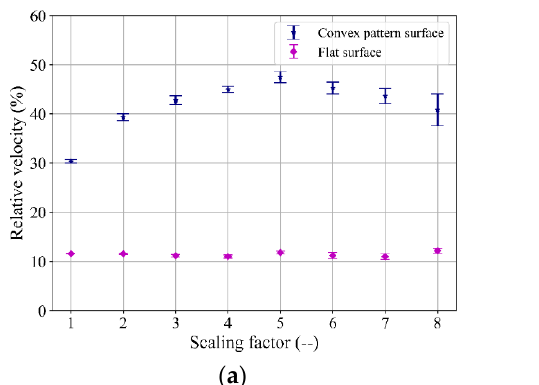
Figure 15. Comparison of the relative velocity and wear rate. ( a ) Relative velocity; ( b ) Relative wear rate.